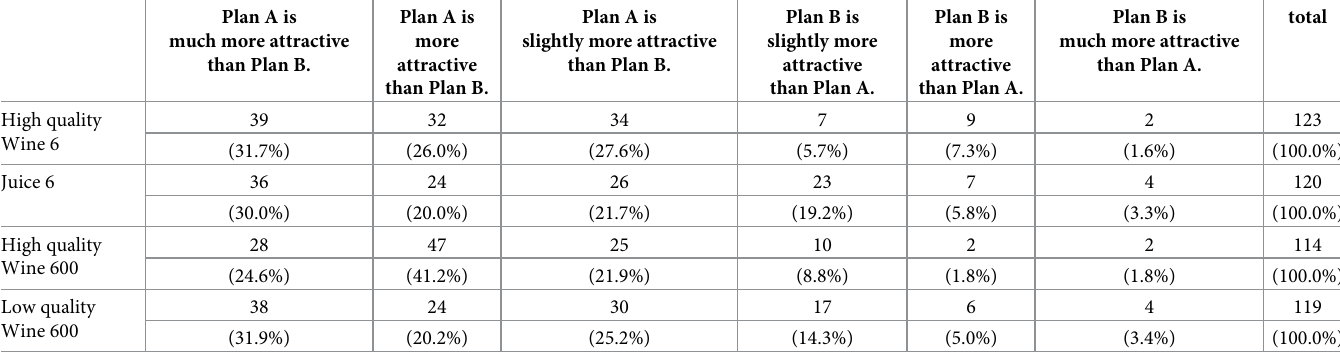
Table 6. Frequencies and percentages of choice in the Drink problem across 4 categories without minority (positive frame). Plan A is much more attractive than Plan